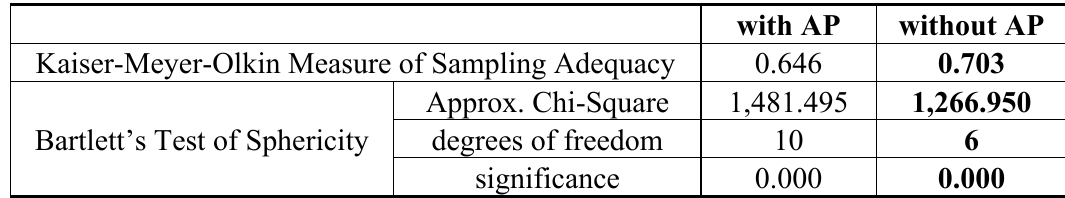
Table 1. Kaiser Meyer Olkin and Bartlett’s Test of meteorological variables, with and without air pressure (AP).